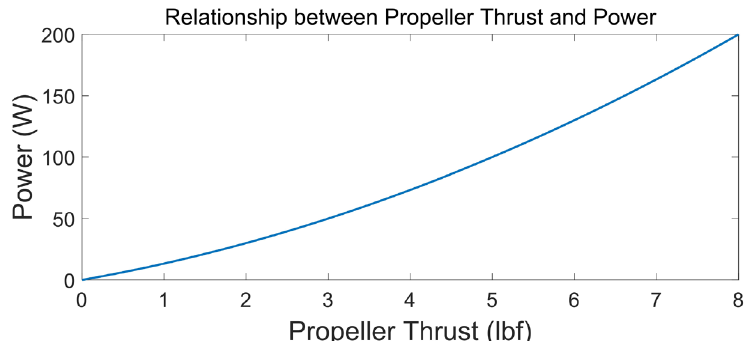
Figure 11. Relationship between the propeller thrust and power.